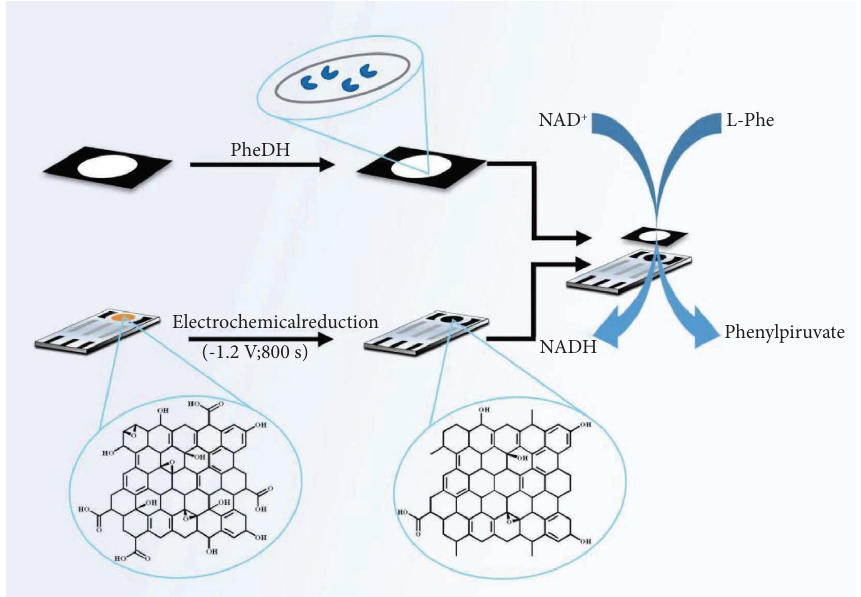
Figure 2: Diagram of the electrochemical paper-based analytical device for Phe detection in neonatal samples (reprinted from reference